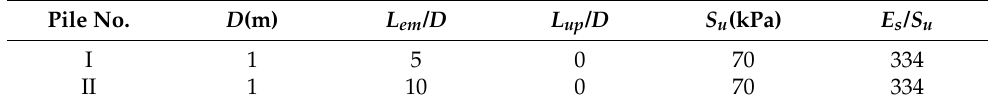
Table 3. Parameters of monopiles and soil condition for case 1.